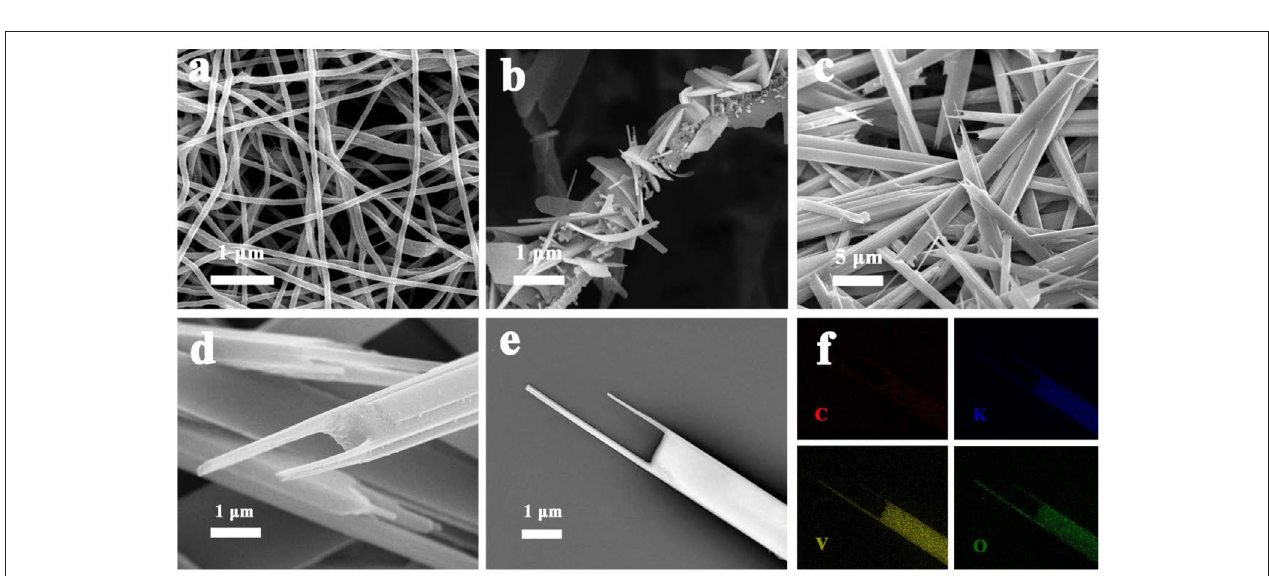
FIGURE 2 | Different magnifications of SEM images of: (a) the precursor nanofibers and K 2 V 8 O 21 nanostructures that were annealed at (b) 350 ◦ C, (c–e) 500 ◦ C; (f) Elemental mapping images of K 2 V 8 O 21 compound with the element of C, K, V,